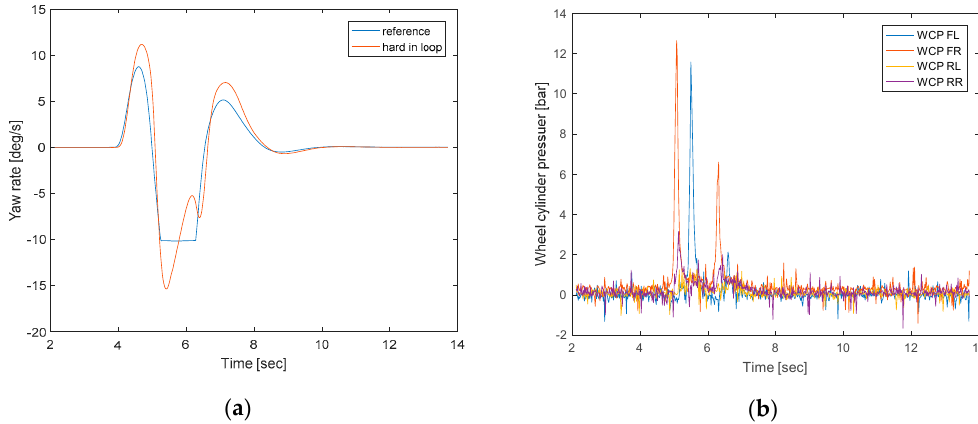
Figure 16. Test results based on the conventional PID-based controller at 𝑢 = 100 km/h and 𝜇 = 0.5. ( a ) is a comparison of the nominal and actual values of the yaw rate, and ( b ) is the wheel cylinder pressure value collected from the wheel cylinder pressure sensor.